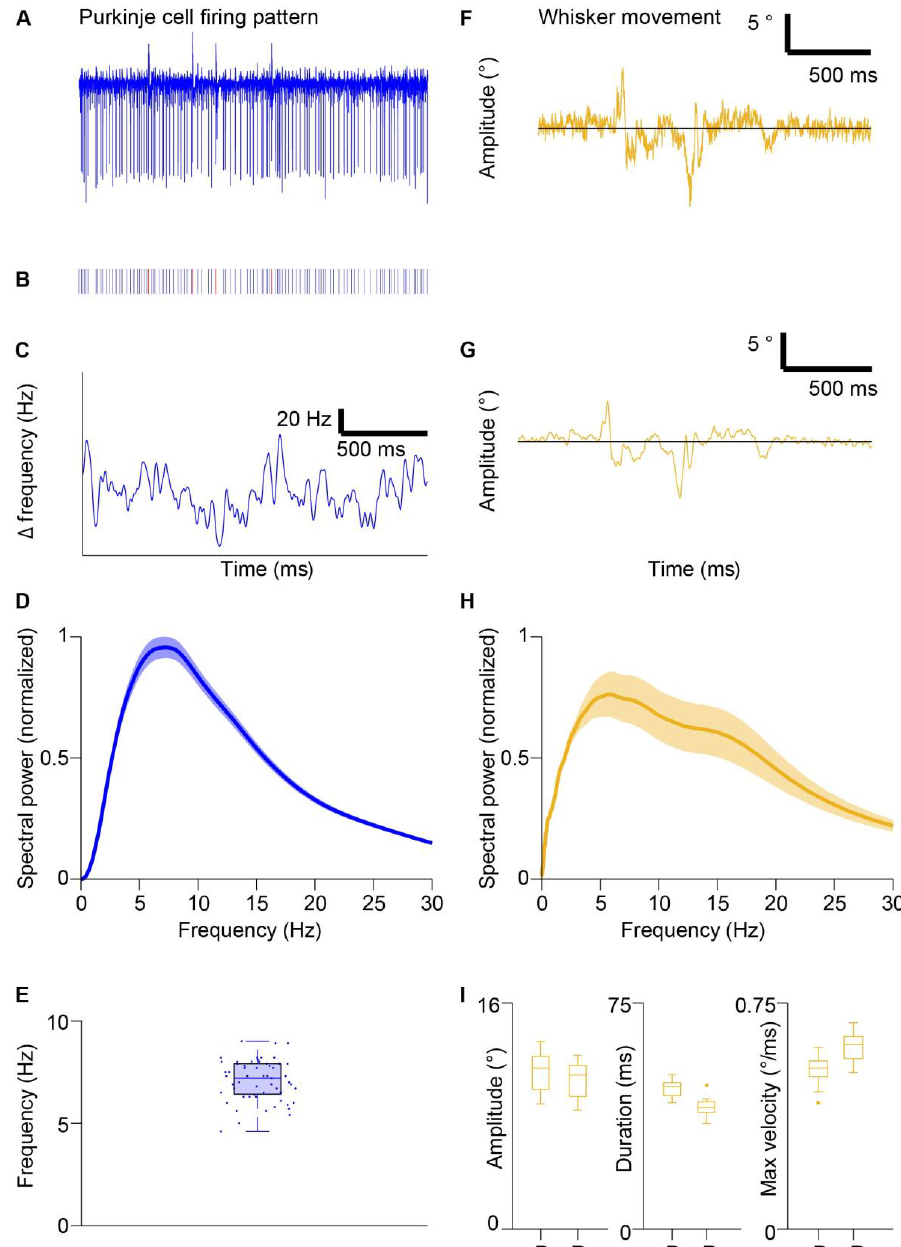
Figure 1. Oscillatory frequencies of simple spiking and whisking kinematics. ( A ) shows an example of raw trace of a PC recording before spike sorting. ( B ) shows the spike train of SSs (in blue) and complex spikes (in red) extracted from the raw trace of ( A ). ( C ) shows corresponding instantaneous frequency from ( A , B ). ( D ) shows a power spectrum of SS instantaneous frequency during periods of movement, calculated with the continuous wavelet transform. The line displays the mean and shaded areas display ± SD, n = 59 cells. ( E ) shows a boxplot of frequencies with a maximum power of power spectra summarized in ( D ), 7 ± 1 Hz (mean ± SD), n = 59 cells. The value of each cell is shown as a dot. ( F ) shows an example of raw whisker trace. ( G ) shows a filtered whisker trace from ( F ). ( H ) shows a power spectrum of whisking during periods of movement, n = 13 mice. Line displays mean and shaded areas display ± SD. ( I ) shows a boxplot with amplitude, duration, and maximum velocity of protractions (P) and retractions (R) during voluntary whisking. Boxplots indicate mean and interquartile ranges. The dots indicate the